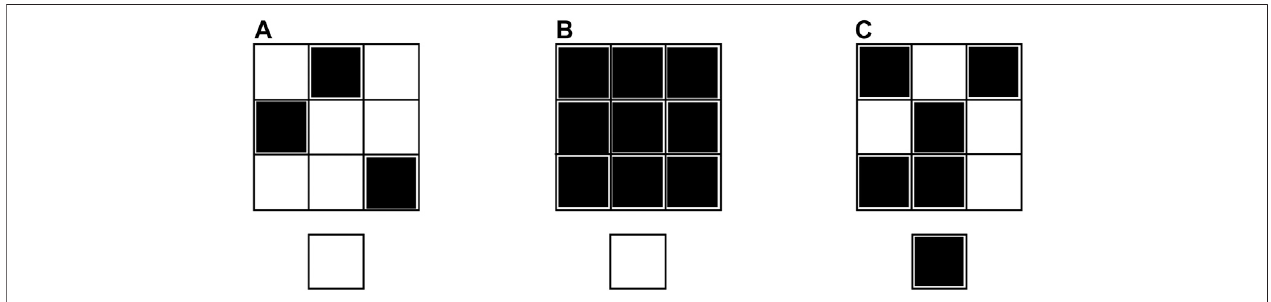
FIGURE4| GraphicalillustrationoftheapplicationoftheEDGECNNlocalrules1for n B (cid:1) 3 (A) ,2 (B) ,and3for n B (cid:1) 4 (C) .Eachofthethreeplotsvisualizes,ontop, a 3 × 3 pattern around the pixel located at row i and column j in the input binary image, and, below, the pixel at position ( i , j ) in the output binary image at